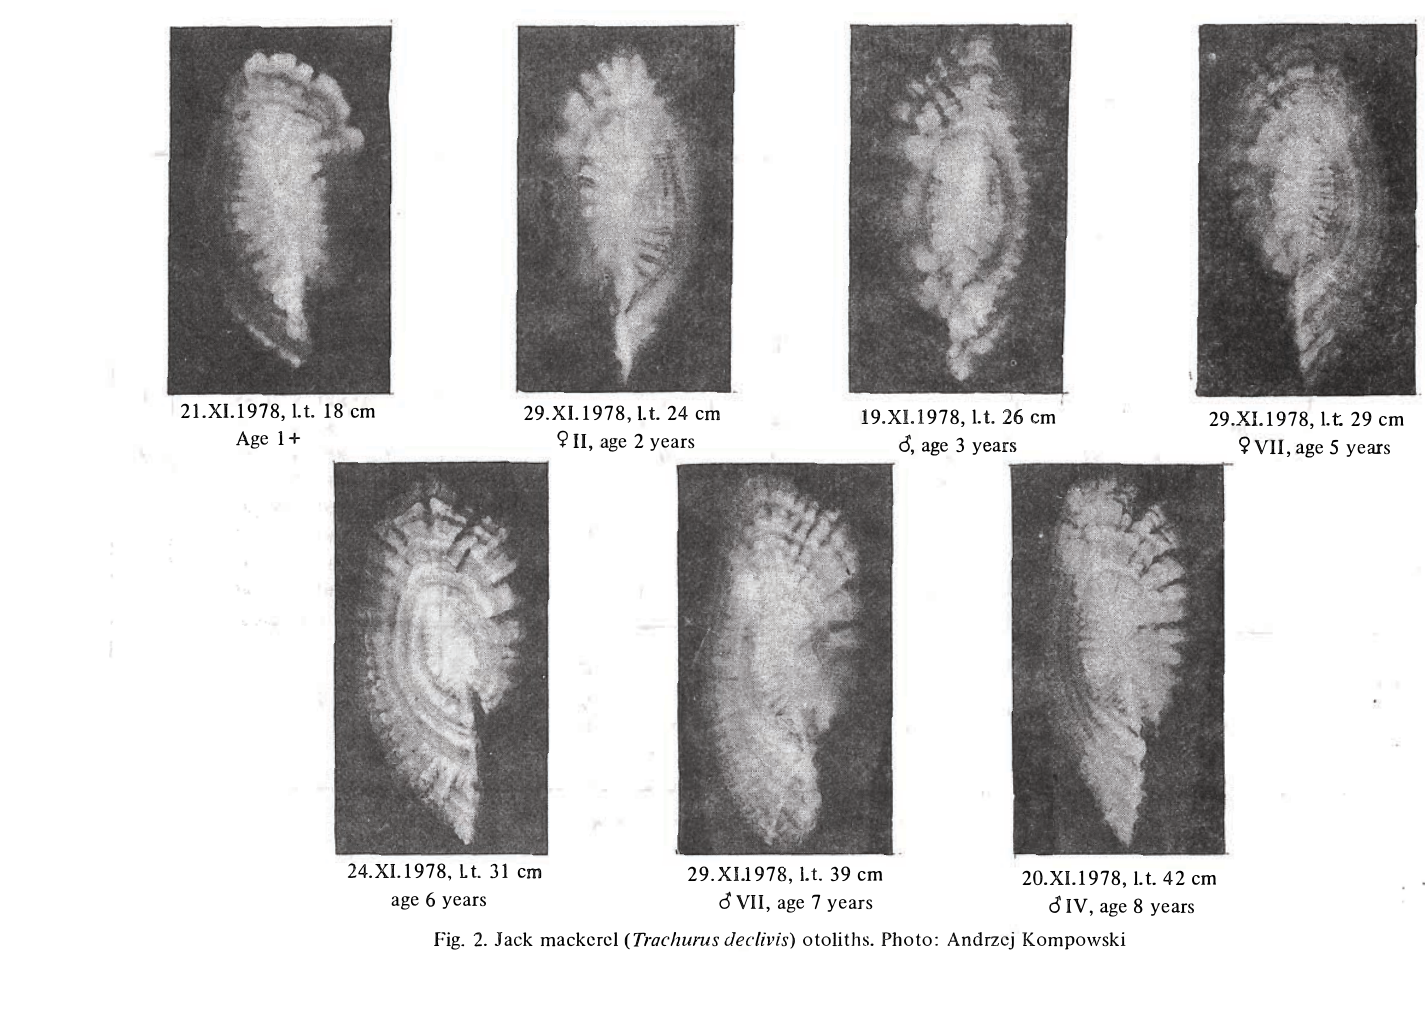
Fig. 2. Jack mackerel (Trachurus dec!ivis) otoliths. Photo: Andrzcj Kompowski